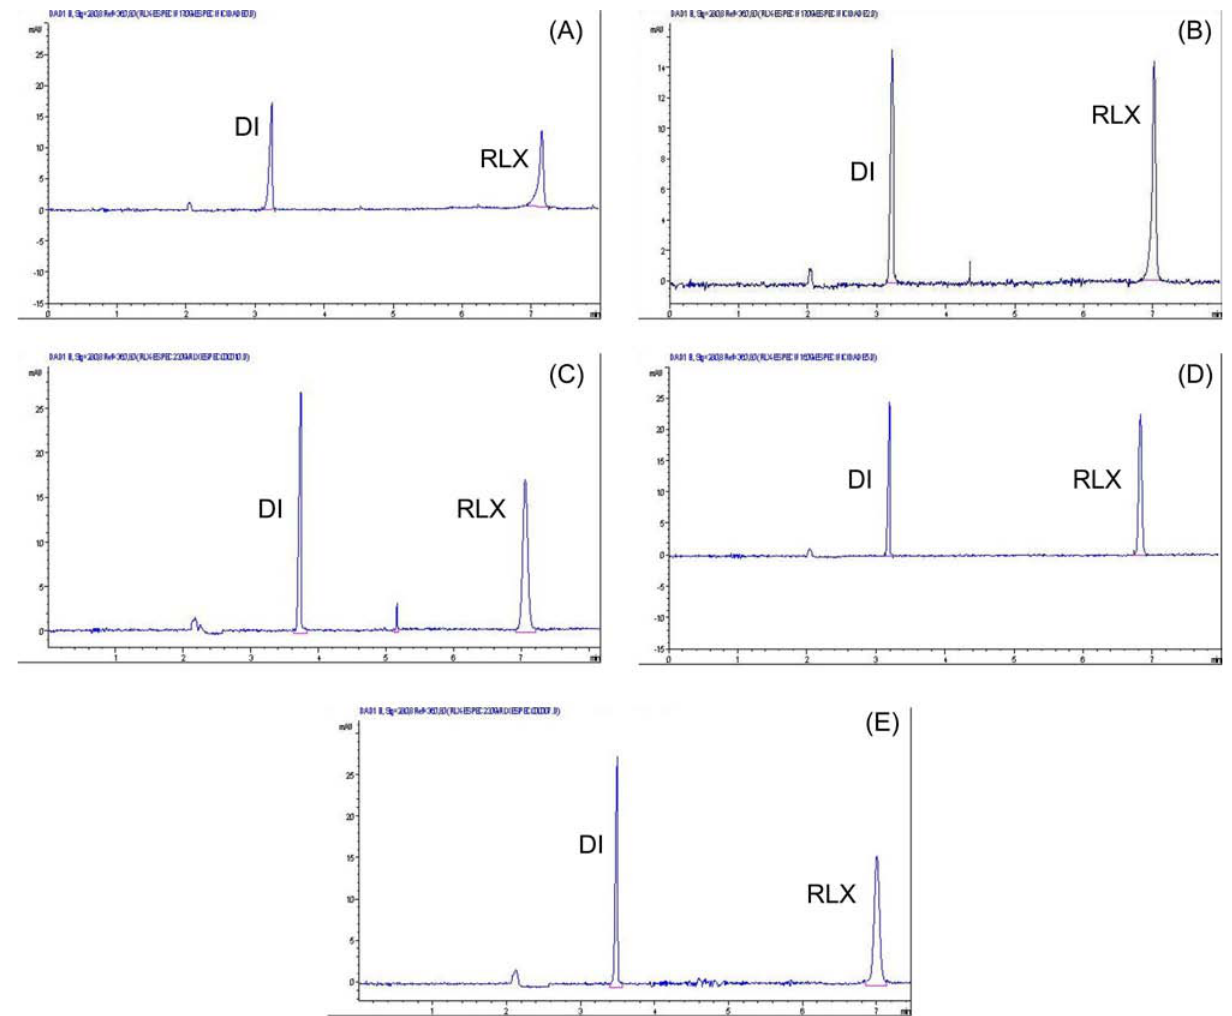
O 3.0%), (D) photolytic stress (UV 352 nm) and 2 2